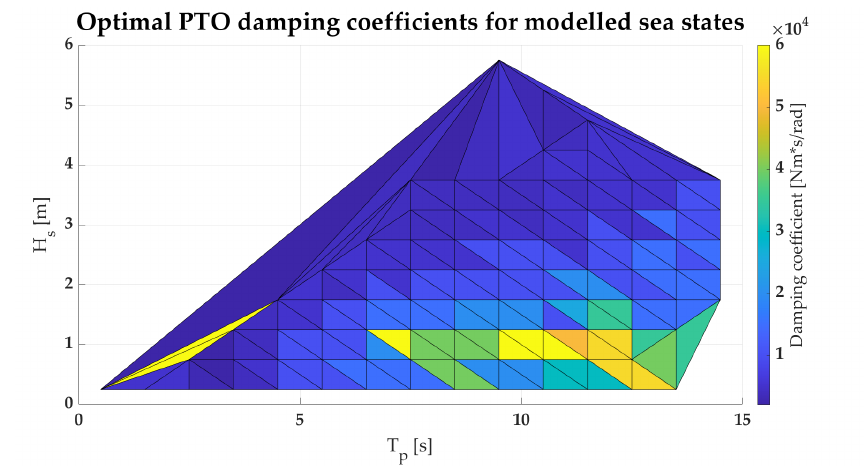
Figure 13. Optimal PTO damping coefficients for the modelled sea